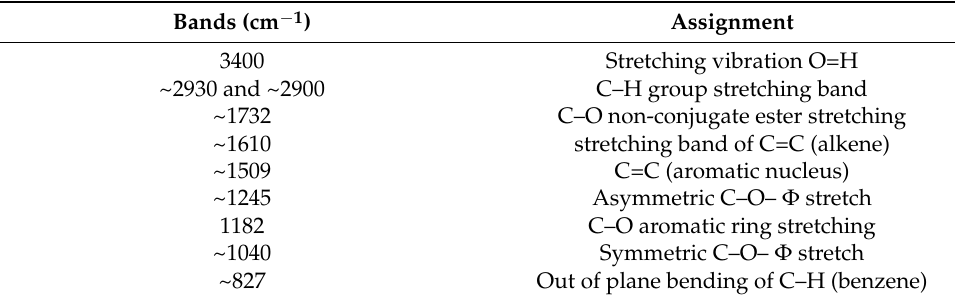
Figure 12. FTIR spectrum of E-glass/epoxy control sample and conditioned samples. Table 5. FTIR bands observed in E-glass/epoxy specimens.